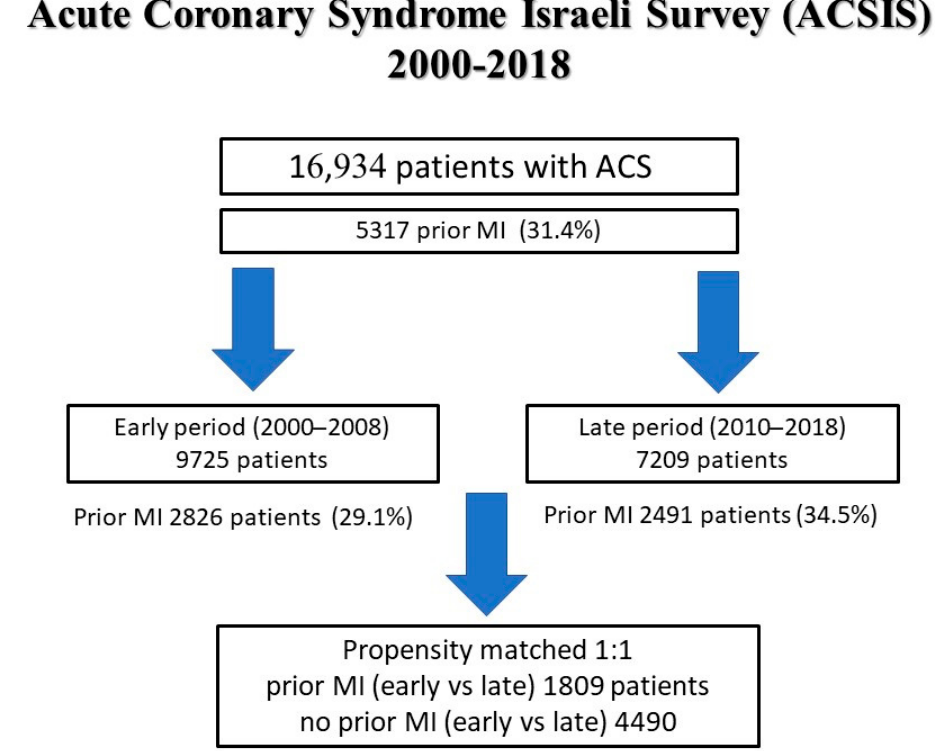
Figure 1. Study flow chart.